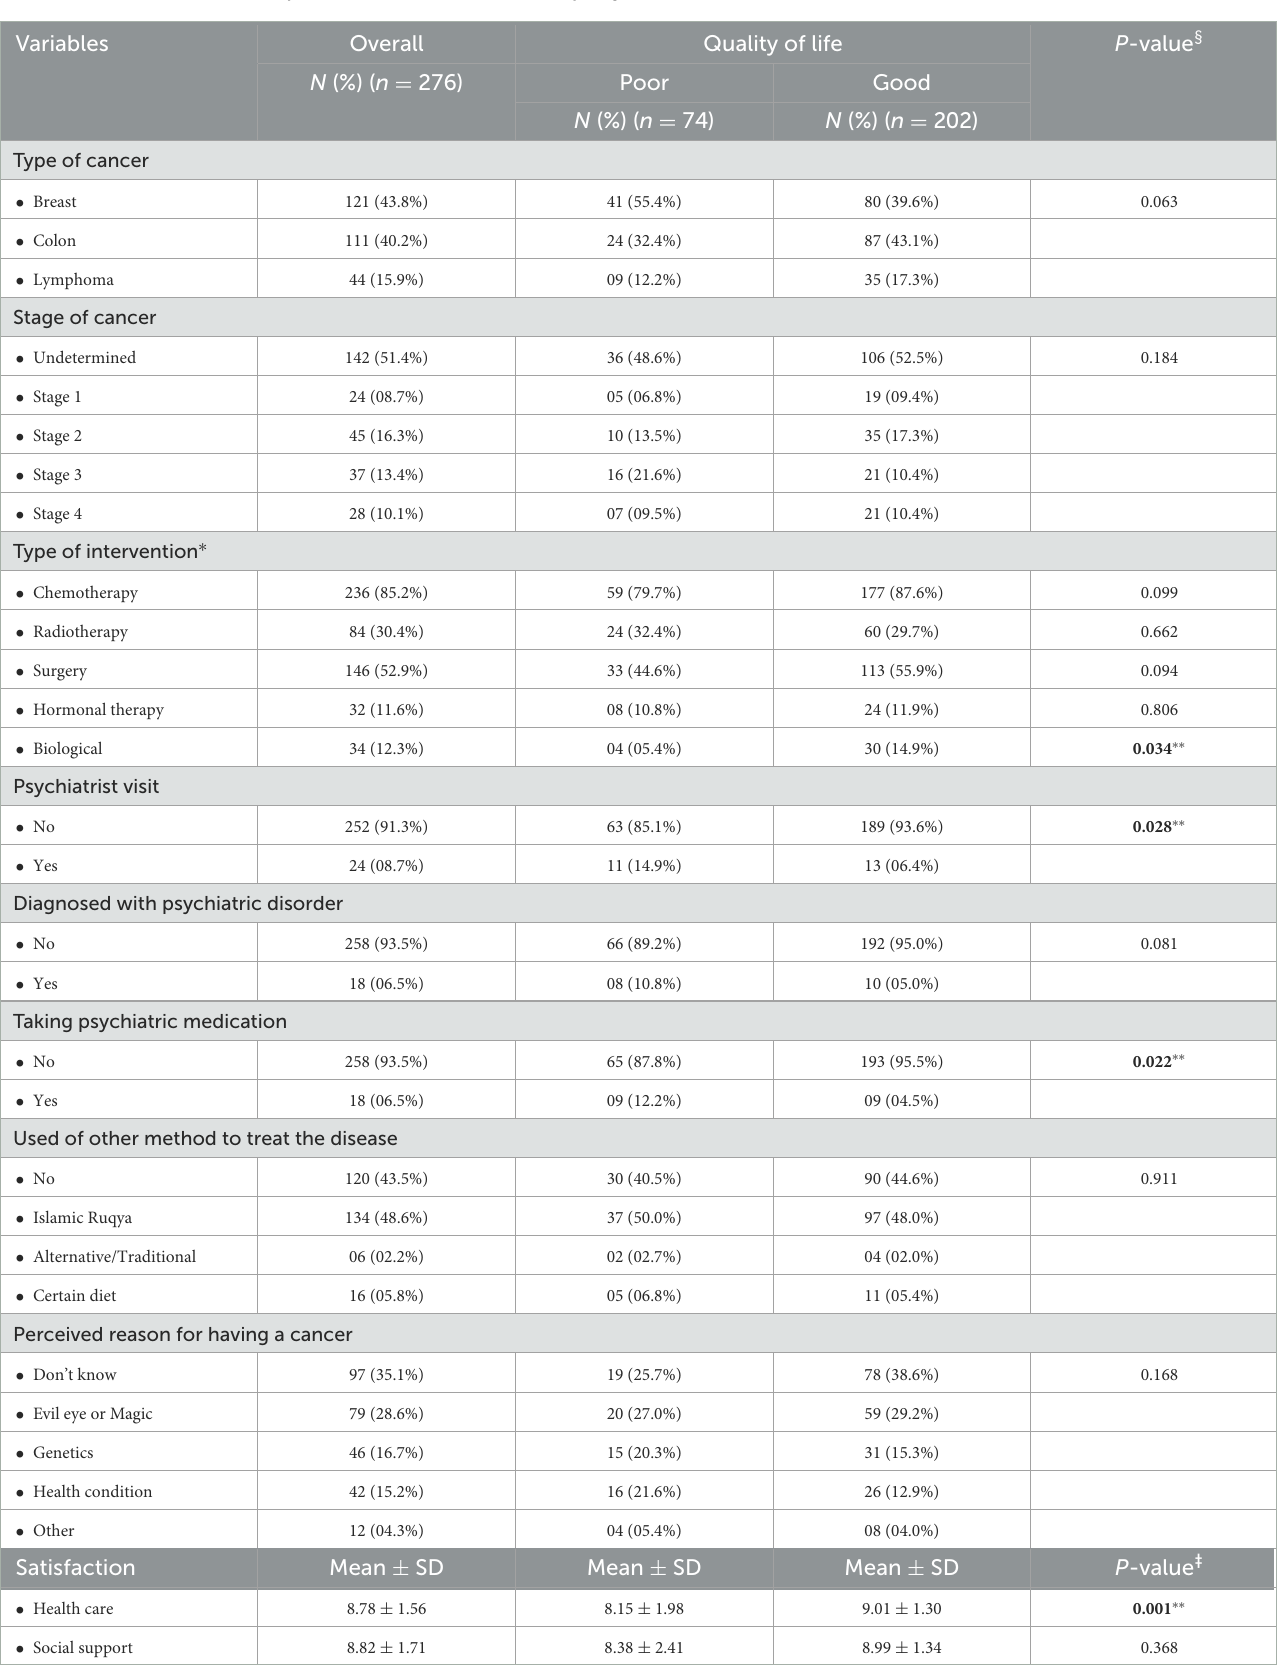
TABLE 2 Clinical characteristics of patients with cancer in relation to quality of life. Variables Overall Quality of life P -value § N (%) ( n = 276) Poor Good N (%) ( n = 74) N (%) ( n =